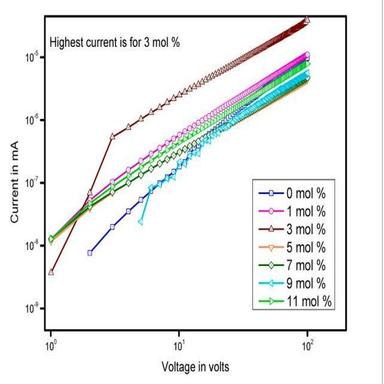
I–V for Sr2MgSi2O7:Dy3þ NPs.